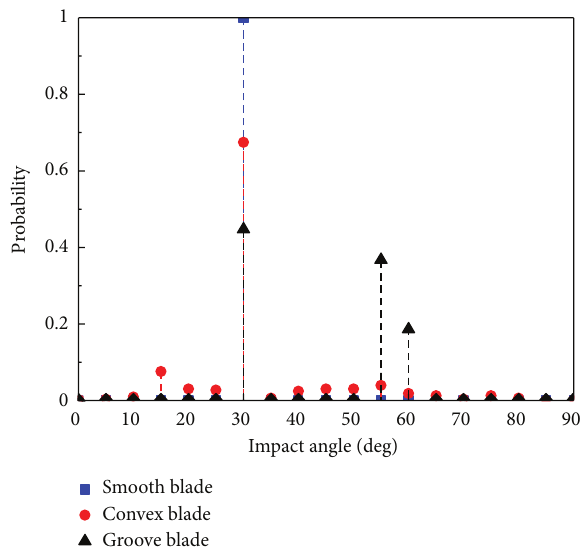
Figure 8: Particle-surface impact angle distribution.